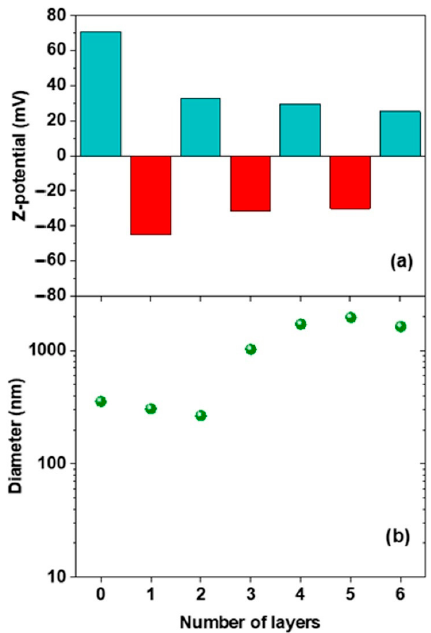
Figure 4. The dependence of the ζ -potential ( a ) and particle size ( b ) on the cellulose derivative type and number of layers deposited. The first values in both panels refer to the bare DDAB vesicle. The average standard deviation is lower than 5% for the first 3 layers and below 10% for the subsequent four to six layers.